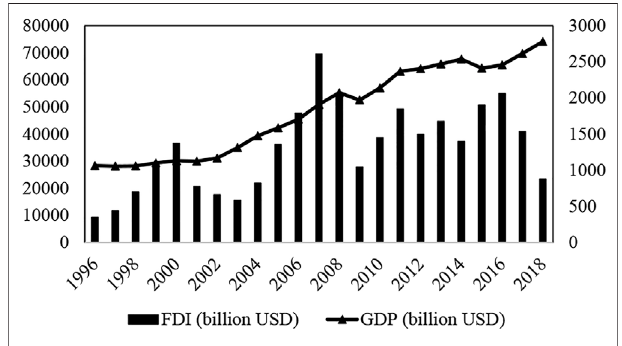
FIGURE 2 | The changing trends of FDI and GDP in G20 economies from 1996 to 2018.